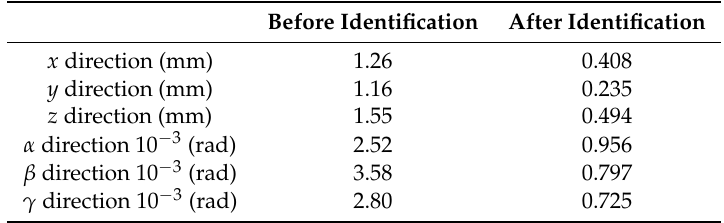
Figure 12. The pose trajectories of the parallel robot: the measurement of the real plant ( black dot ), the output of the simulation with initial parameters ( green line ), the output of the simulation with identified parameters ( blue line ), ( a ) Along X Direction; ( b ) Along Y Direction; ( c ) Along Z Direction; ( d ) Around α Axis; ( e ) Around β Axis; ( f ) Around γ Axis. Table 3. The RMS levels of the pose trajectory